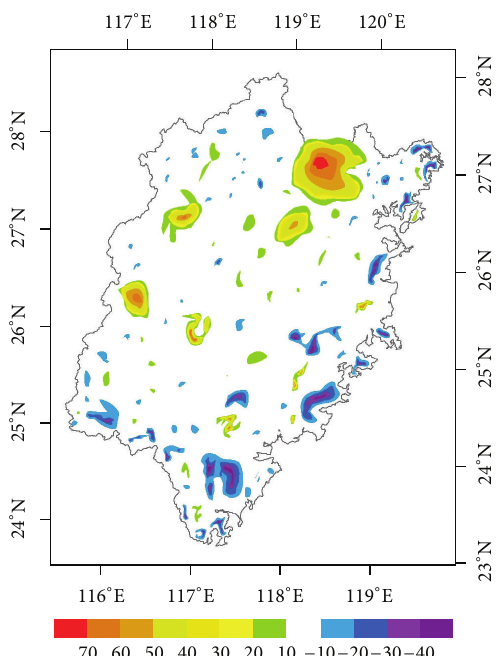
Figure 4: Annual average precipitation difference (unit: mm) in the experiment of conversion from grassland to forestland in Fujian province,